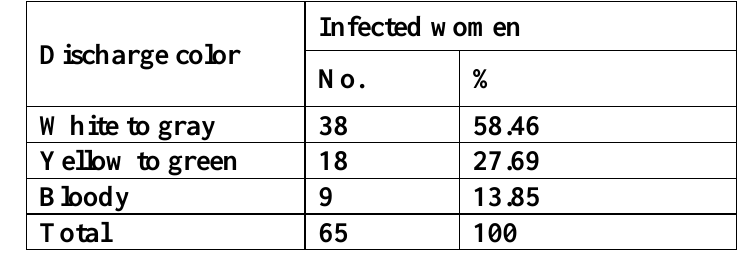
Table (4): Relation between vaginal discharge color and Trichomoniasis infection.